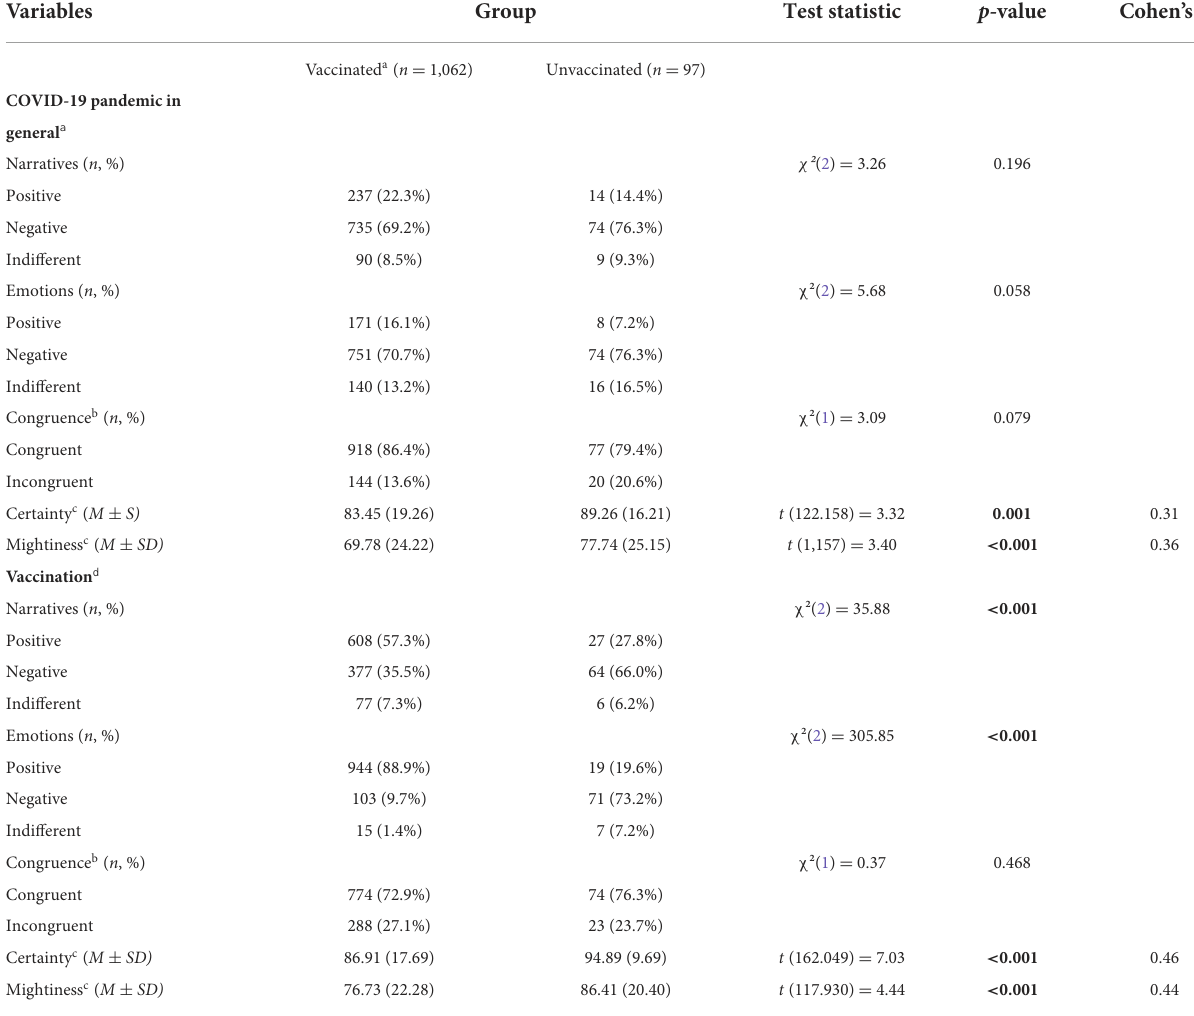
TABLE 4 Descriptive statistics of the believing parameters of vaccinated and unvaccinated workers in the healthcare sector ( n = 1,159). Variables Group Test statistic p -value Cohen’s d Vaccinated a ( n = 1,062) Unvaccinated ( n = 97)